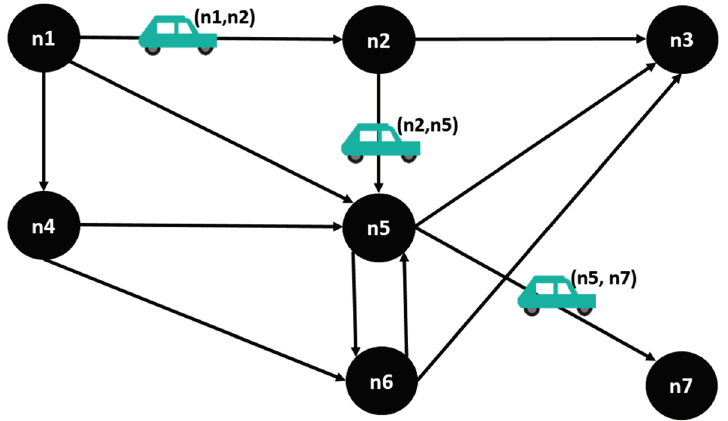
Figure 8. Illustration of a vehicle’s route in the vehicular